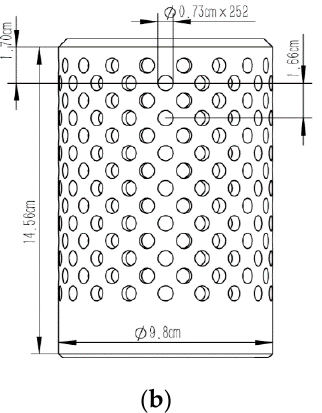
Figure 3. ( a ) Structural size of the test section; ( b ) structural size of the nozzle.